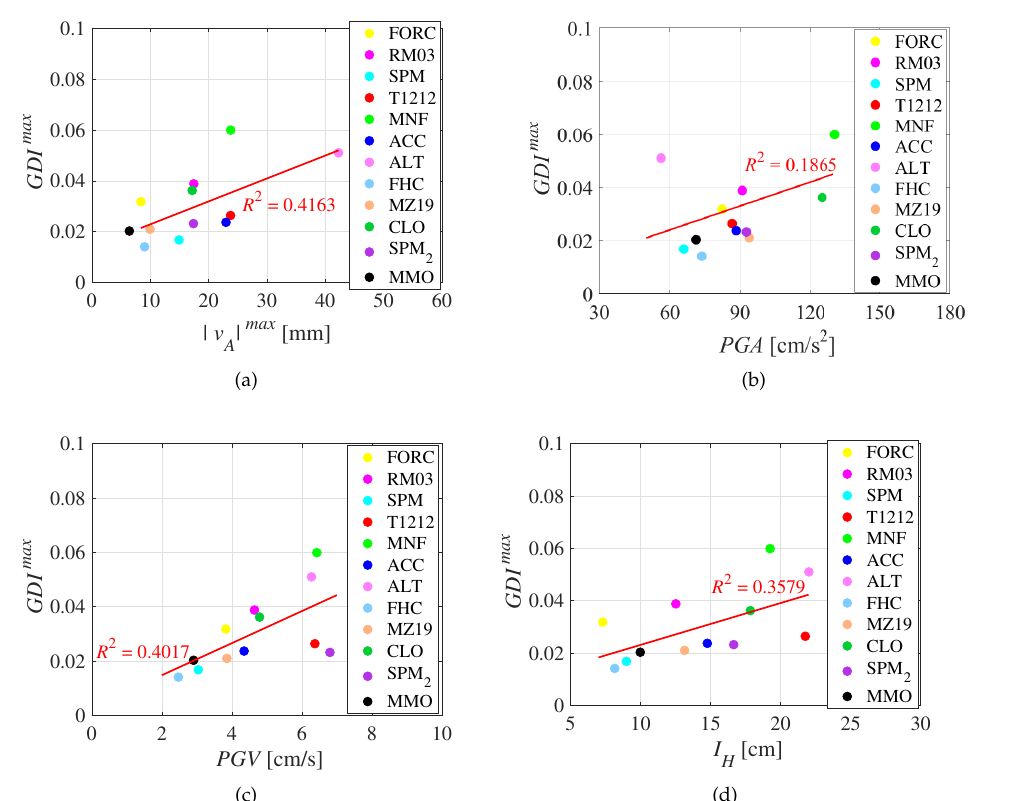
Figure 23. Individual events: correlations between maximum Global Damage Index GDI max and ( a ) maximum displacement response | v A | max , ( b ) PGA , ( c ) PGV , and ( d ) Housner intensity I H